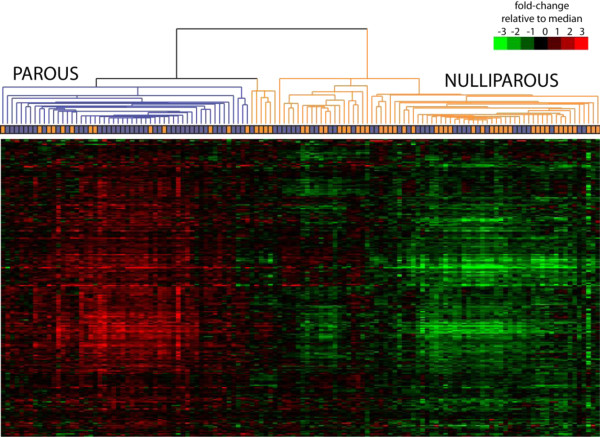
Unsupervised HeatMap cluster analysis. The heatmap illustrates our analysis of the 251 parity-related gene expression profiles of normal breast samples from cancer-free women who had undergone reduction mammoplasty surgery at Baystate Medical Center (Springfield, MA, USA) and whose tissue is banked at the Pioneer Valley Life Sciences Institute.